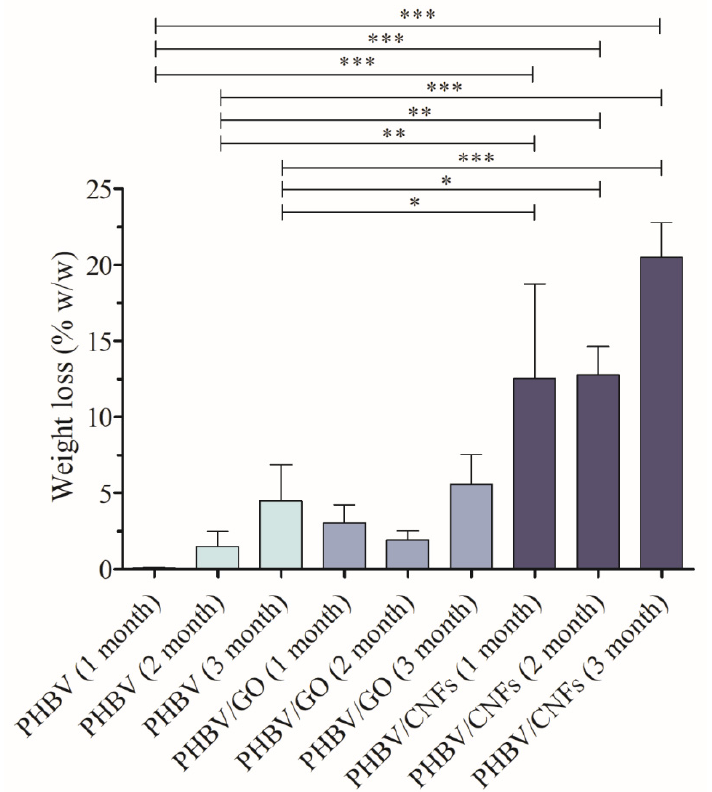
Figure 2. Weight loss of PHBV, PHBV/GO and PHBV/CNFs after degradation in acid aqueous medium (pH = 6) for 1, 2 and 3 months. Data are shown as mean ± standard deviation. Significant differences between samples were calculated by one-way ANOVA with Tukey’s correction. Only the significant differences are indicated in the graph with their level of significance: * p > 0.05; ** p > 0.01; *** p > 0.001.